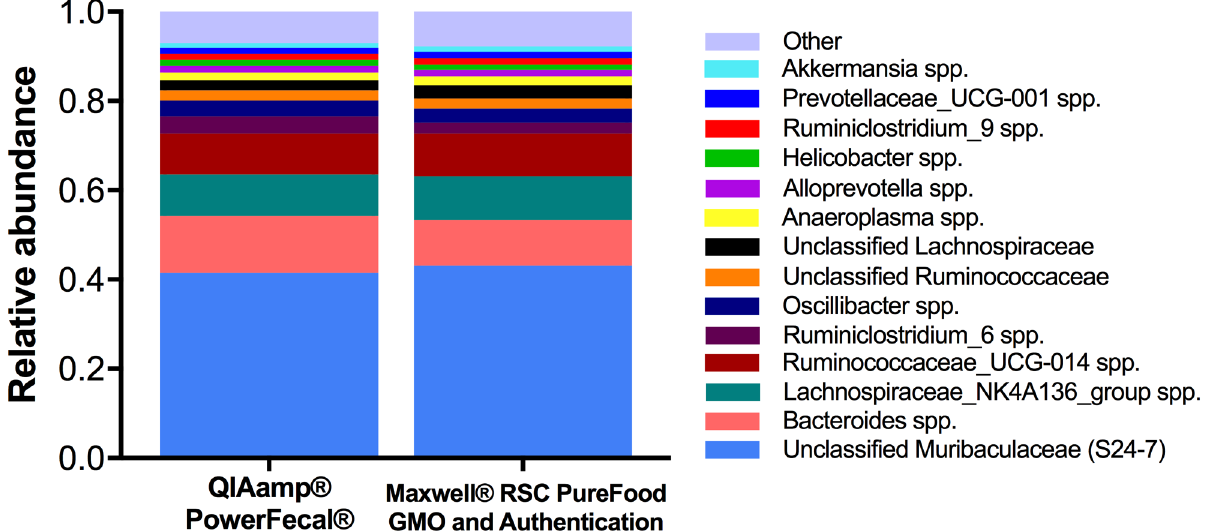
Fig 3. Comparison of DNA extraction methods on next generation sequencing (NGS) relative abundance at the genus level. NGS using DNA extracted with the QIAamp 1 PowerFecal 1 Kit ( n = 40) and the Maxwell 1 RSC PureFood GMO and Authentication Kit ( n = 39) revealed similar proportions of most prominent genera. Bacterial genera with a relative abundance (cid:21) 0.01 (1%) are visualized here. Relative abundances (mean ± s.d.) for the top 30 most abundant genera are available in S2